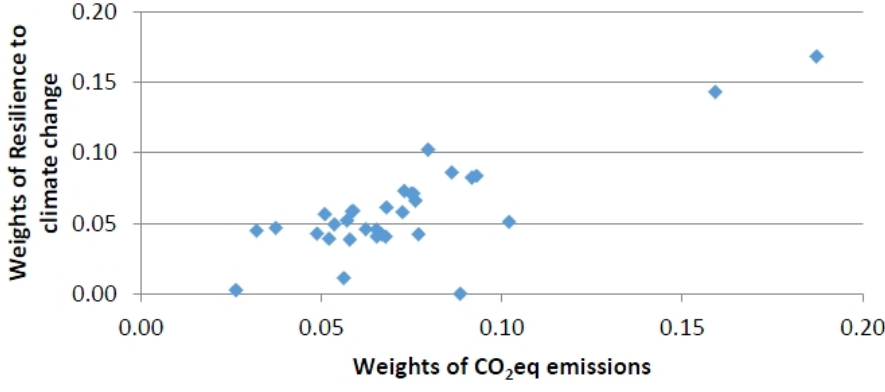
Figure 6. Relationship of weights of “CO 2 eq emissions” and “resilience to climate change”.